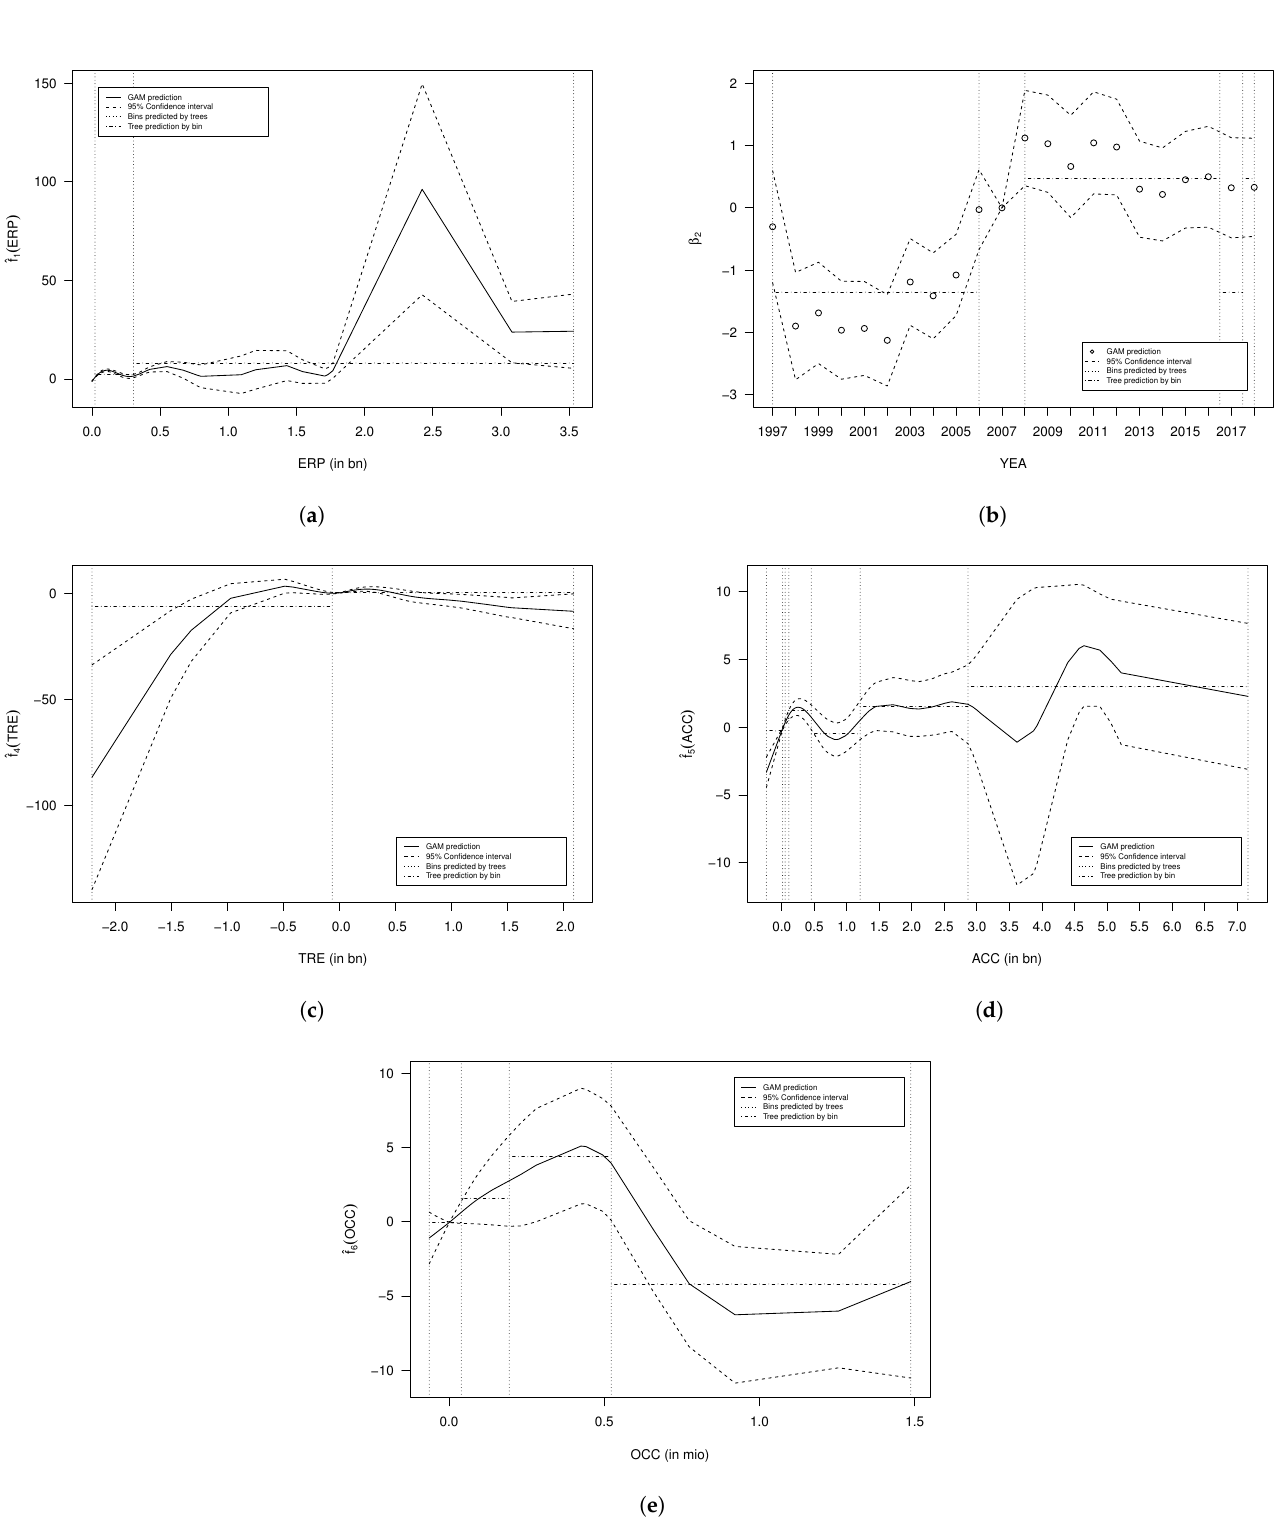
Figure 1. Effects on the equalization reserves for reinsurance undertakings. ( a ) Effect of the equal- ization reserves of the previous year. ( b ) Effect of the calendar year. ( c ) Effect of the technical result. ( d ) Effect of the accumulation and commission costs. ( e ) Effect of the other